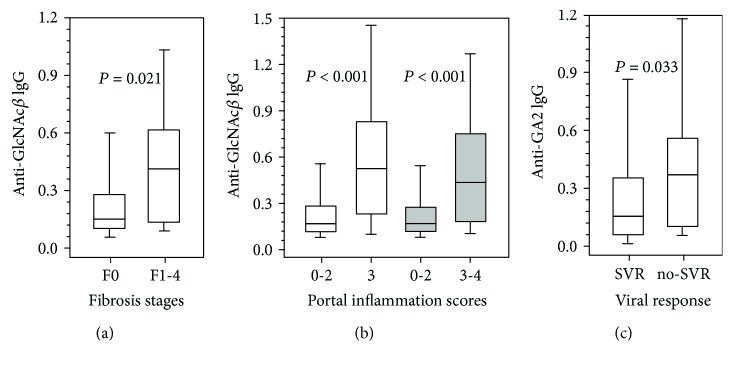
(a) Association of the anti-GlcNAcβ IgG level with the stages of fibrosis in patients infected with HCV-1b (cut-off 0.334). Y-axis: Ab level values (Atest minus Acontrol). The lower boundary of the box indicates the 25th percentile data, a line within the box marks the median (M), and the upper boundary of the box indicates the 75th percentile. The bars below and above the box indicate the 10th and 90th percentiles, respectively. (b) Association of the anti-GlcNAcβ IgG level with portal inflammation scores. Light boxes symbolize patients infected with HCV-1b and 3a genotypes in stages F0–2 (cut-off 0.248), and dark boxes denote those in stages F0–4 (cut-off 0.248). (c) Association of the pretreatment level of anti-GA2 IgG with the response to antiviral treatment: SVR—patients with sustained viral response (M 0.126); no SVR—patients with nonresponse and relapse (M 0.385), cut-off 0.232.